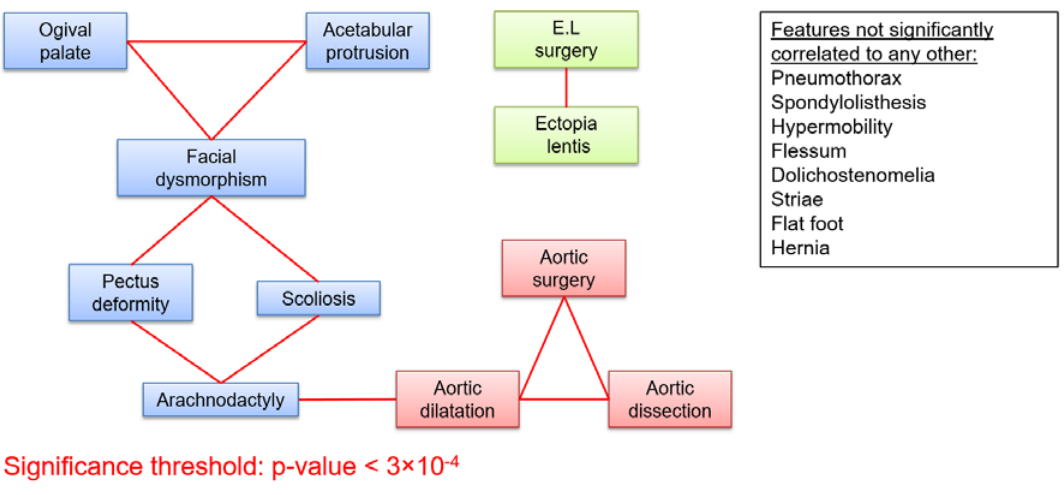
Figure 1. Cross correlations between 19 clinical features of MFS. Clinical features are represented as boxes. Red links between the boxes represent correlations significant after Bonferroni correction ( p < 3 × 10 − 4 ). (E.L.: Ectopia lentis).